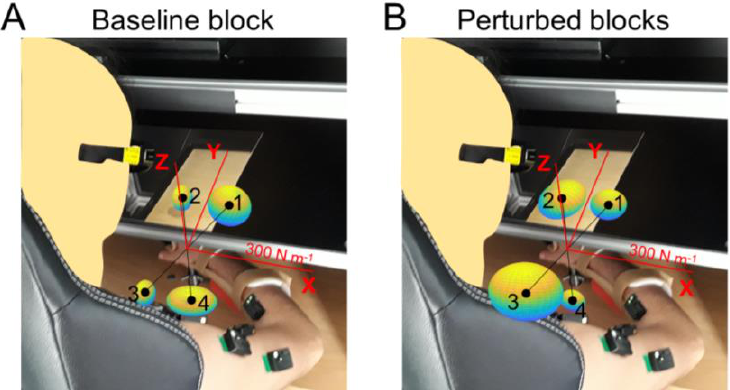
Figure 11. Examples of endpoint stiffness ellipsoids calculated along four force targets lying on the horizontal x / y plane that were collected during the baseline block ( A ) or perturbed blocks ( B ). The stiffness ellipsoids are translated in order to make the ellipsoid center and the target position along which the ellipsoids were calculated, i.e., the black dots, coincident. Numbers close to the target positions refer to the target index. Red lines indicate the reference system, which is centered on the palm when participants are not exerting any endpoint force, and they all have the same length in the space (300 N∙m −1 ). Table 2. VAF calculated with the axes and the volume of the stiffness ellipsoid approximated by the product of the null-space projection of the muscle activation, normalized to the ratio between the mean null-space projection of the muscle activation divided by the mean value of the ellipsoid axes or volume. In the table, both the VAFs calculated by fitting of the norm of the null-space projection obtained from data (“Data”) and the 95% percentile, over 500 repetitions, of the product of the null-space projection of the muscle activation, randomly shuffled during each repetition (“Random”) are reported. VAF reported in bold identifies “Data” values higher than “Random” values. VAF values reported with an asterisk (*) indicate a significant regression ( p < 0.05) of the variable with the norm of the null-space projection of the muscle activation. The penultimate column reports the mean (std) values across participants. The last column reports the p -values of Student’s t -test between the VAF values reported in “Data” with respect to those reported in “Random”. Values reported in bold indicate a significant difference ( p <